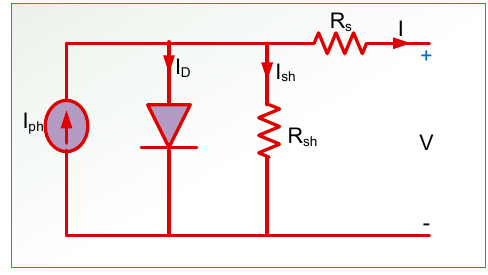
Figure 2. PV cell equivalent circuit.